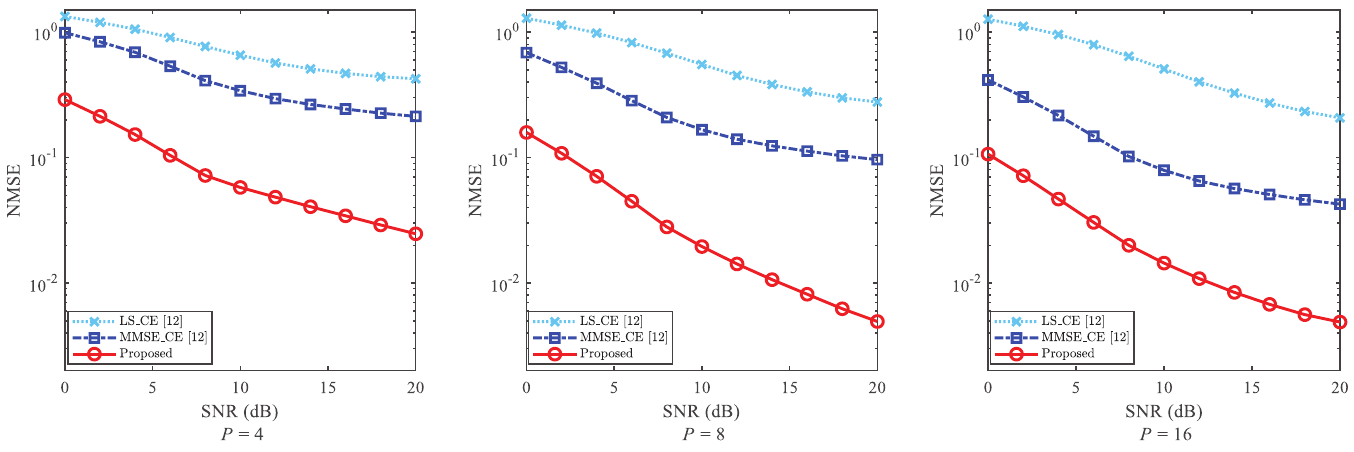
Fig 5. NMSE of CE against the impact of P , where P = 4, P = 8 and P = 16 are considered, respectively.